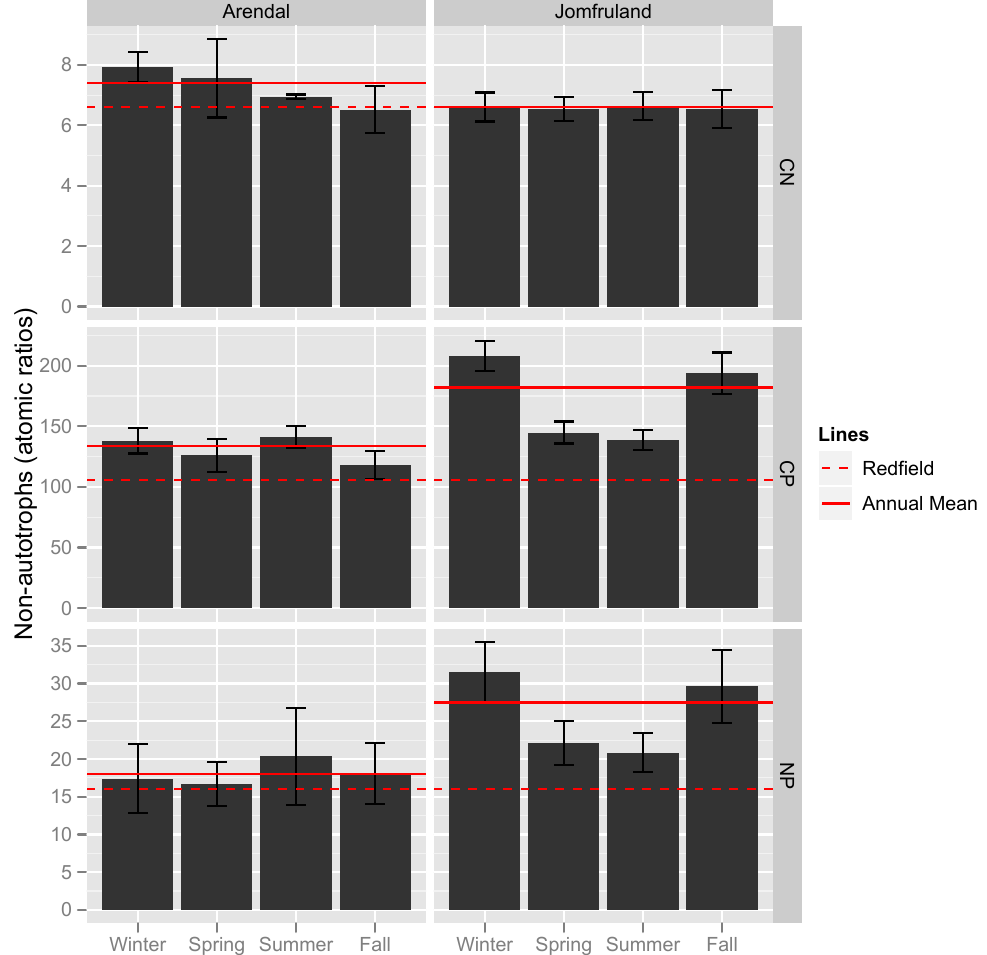
Fig. 11. Calculated C:N, C:P and N:P of non-autotrophic fraction for Arendal and Jomfruland from regression model, with lines showing annual mean ratio and the Redfield ratios. Error bars show the